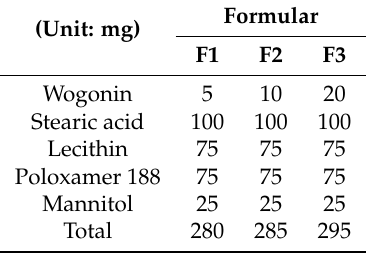
Table 1. Composition of the different wogonin-loaded solid lipid nanoparticles (SLNs). (Unit: mg)